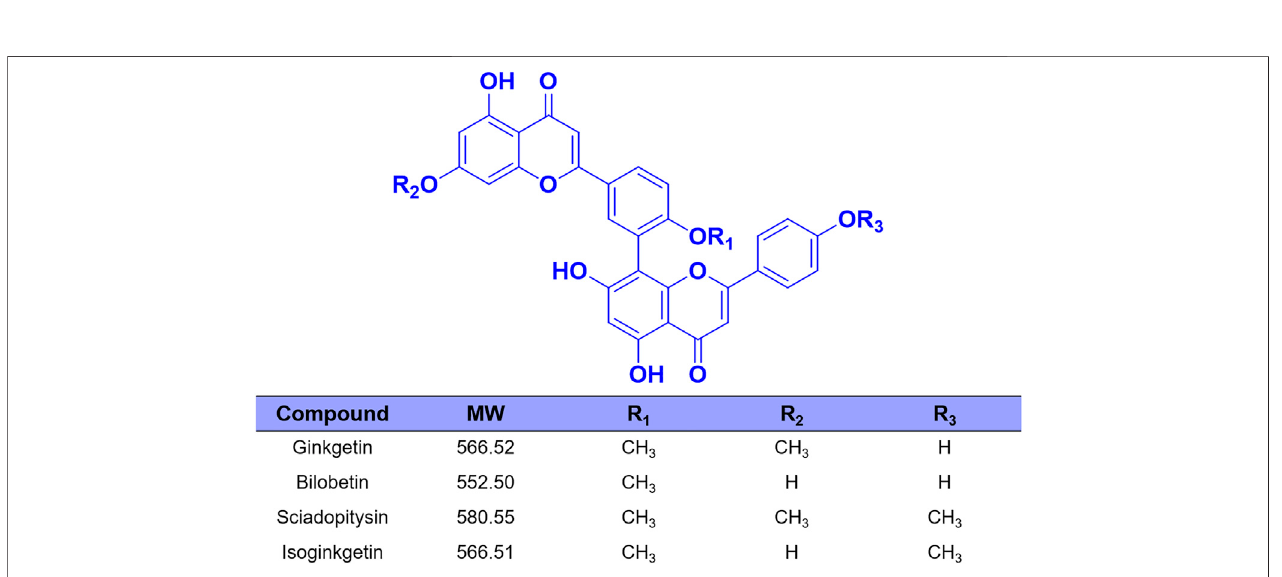
FIGURE 2 | The chemical structures of four bi fl avones from Ginkgo biloba .